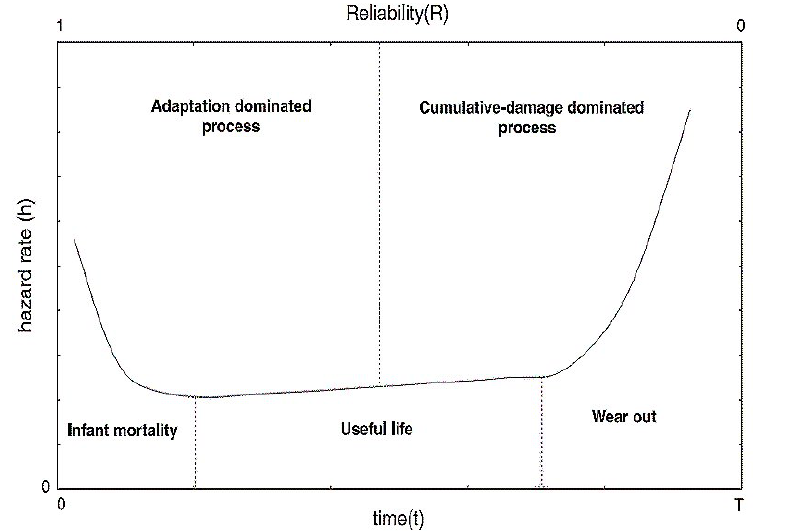
Figure 1. The bathtub curve with three phases.